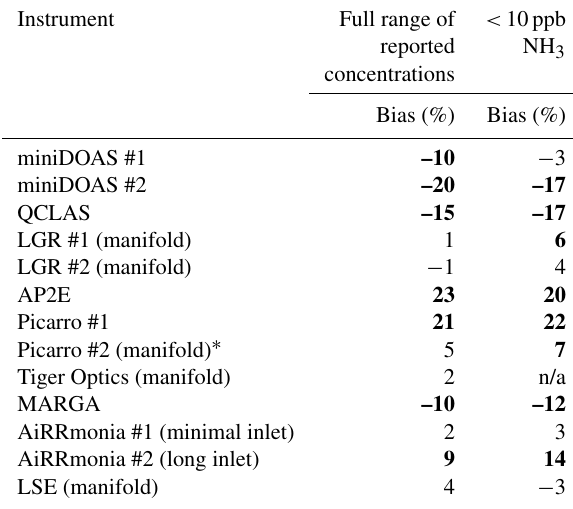
Table 4. Bias calculated from orthogonal regressions (Figs. S4 and S5) of hourly averages from instruments for the period of 22 to 29 August 2016 compared the OGS method. Data were filtered for wind speed and atmospheric stability. Bold data are biases which are > 5%; n/a = not